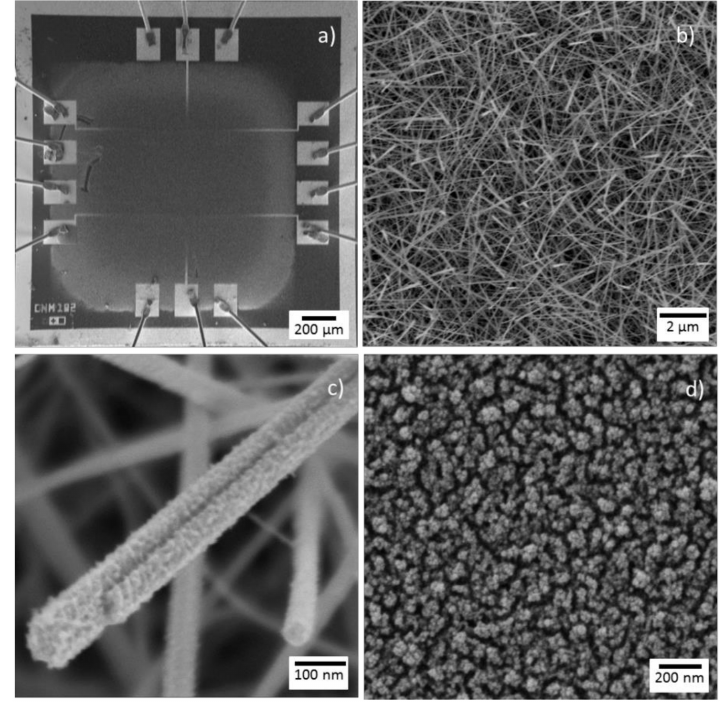
Figure 2. The SEM imaging of a ( a ) gas sensor device, the Ce / W nanowires at ( b ) low and ( c ) high magnification, and ( d ) the non-modified Ce films integrated on the micromachined membrane.